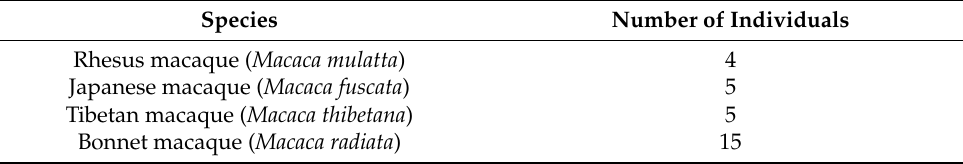
Table 1. The four macaque groups that participated in the training study. Species Number of Individuals Rhesus macaque ( Macaca mulatta ) 4 Japanese macaque ( Macaca fuscata ) 5 Tibetan macaque ( Macaca thibetana ) 5 Bonnet macaque ( Macaca radiata )